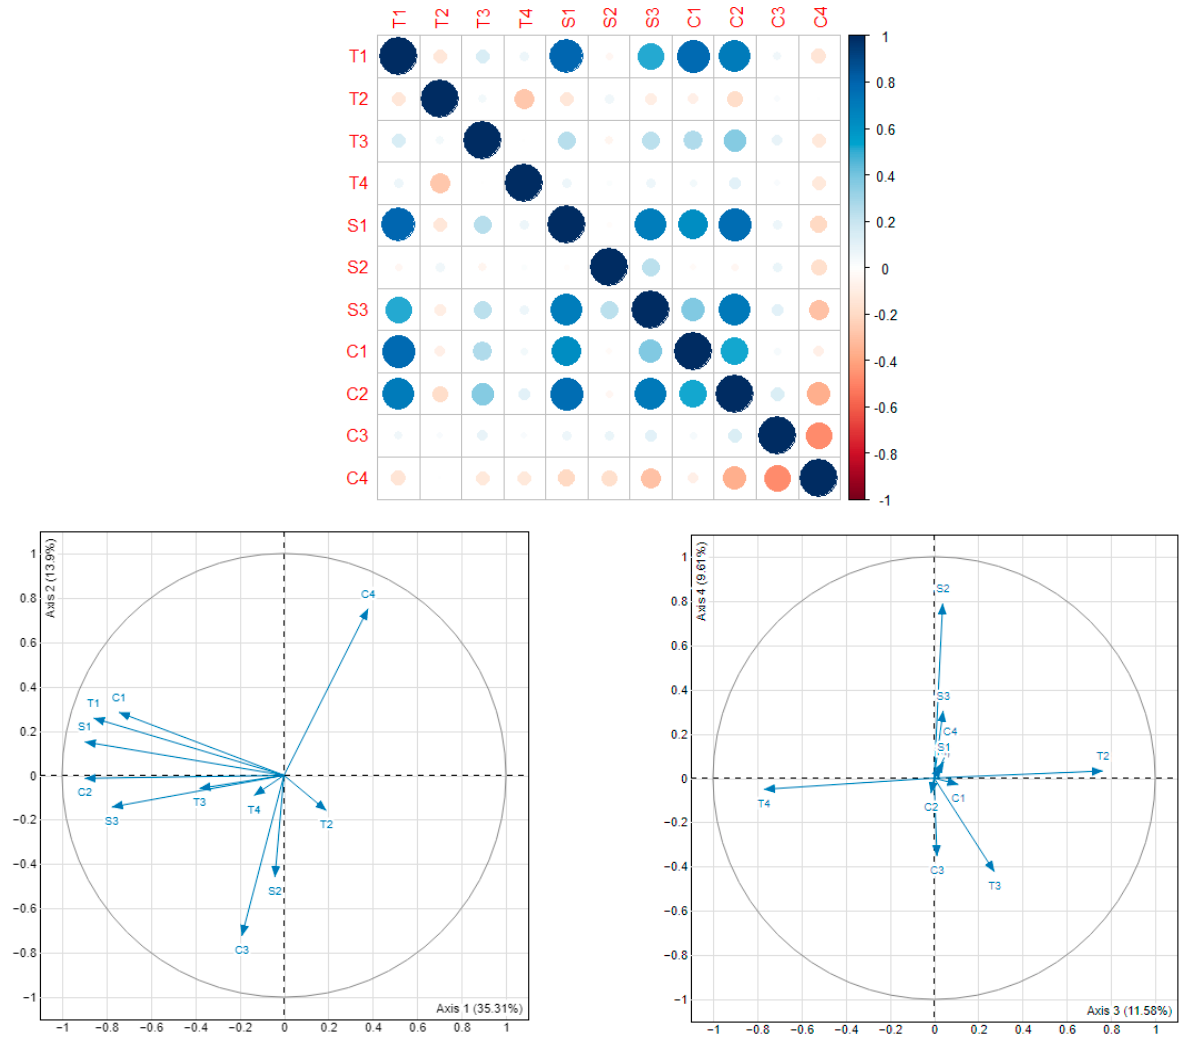
Figure A1. Correlation matrix and PCA plots of the 11 observer profiles metrics (axes 1–2 and 3–4).